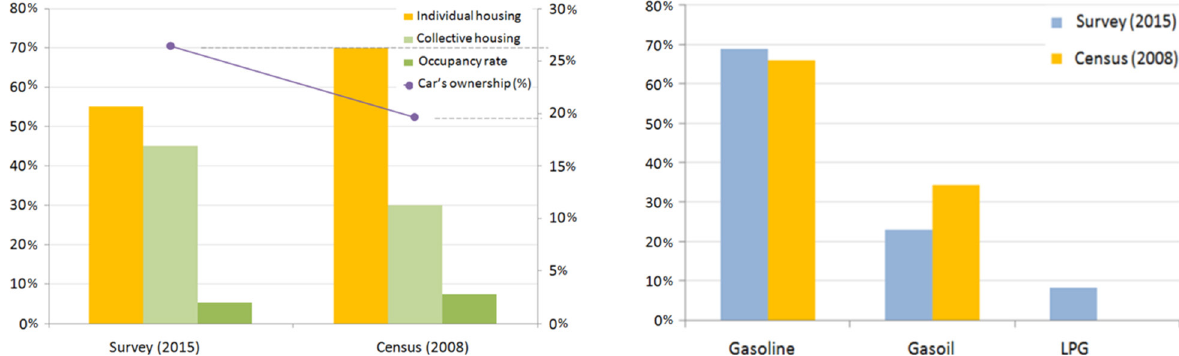
Fig. 7. Comparison between survey’s and census data. Source: own compilation.